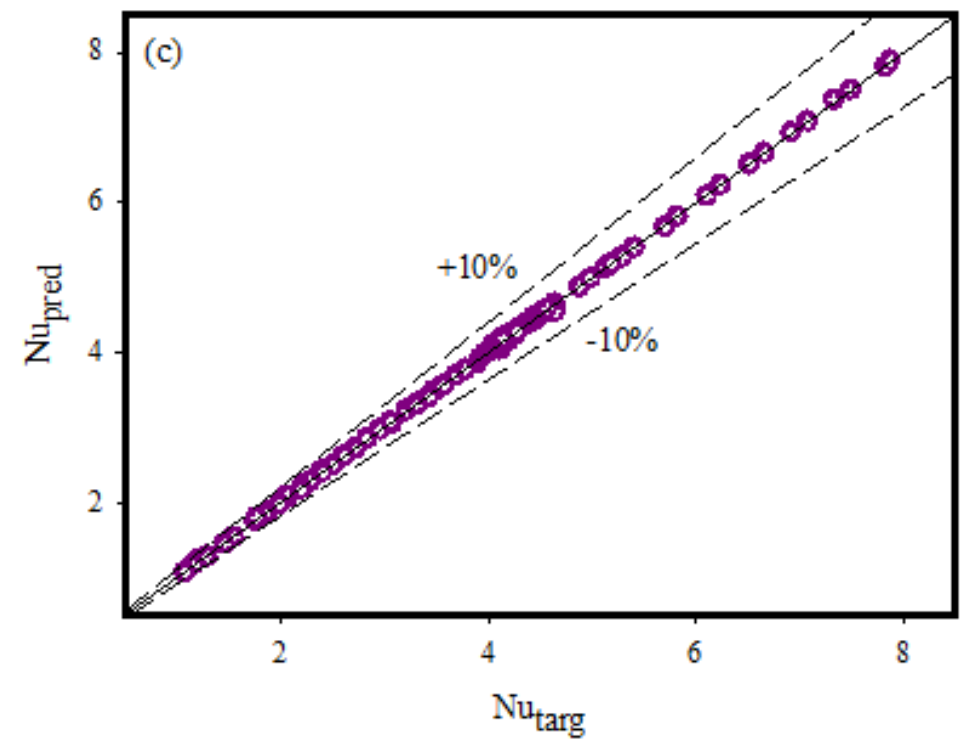
Figure 7. ( a ) The target and prediction values for ANN model-I. ( b ) The target and prediction values for ANN model-II. ( c ) The target and prediction values for ANN model-III.